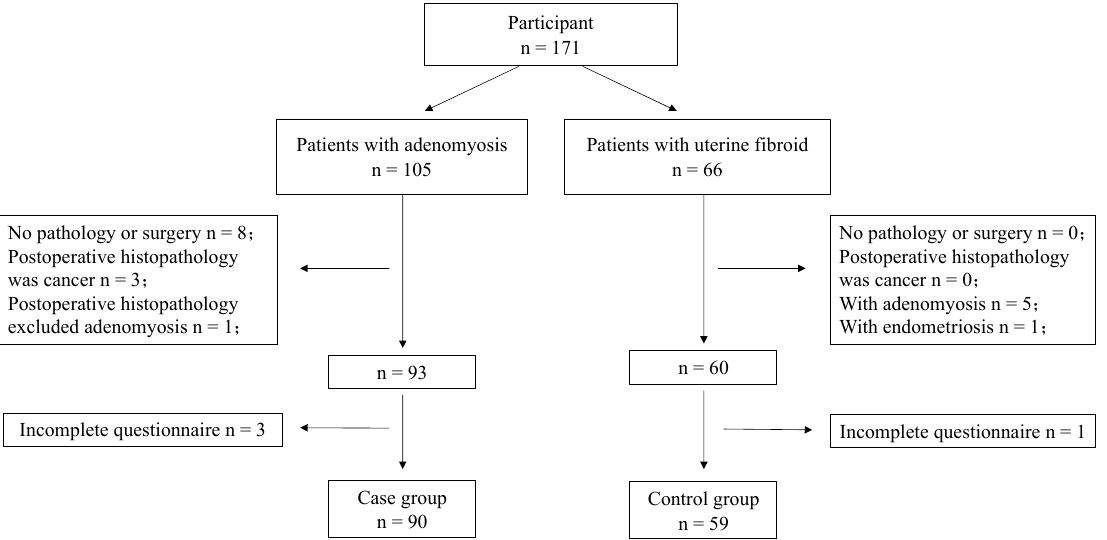
Figure 1. Data collection flowchart. An incomplete questionnaire indicates a patient did not complete the required questionnaire, such as HADS or SF-36.